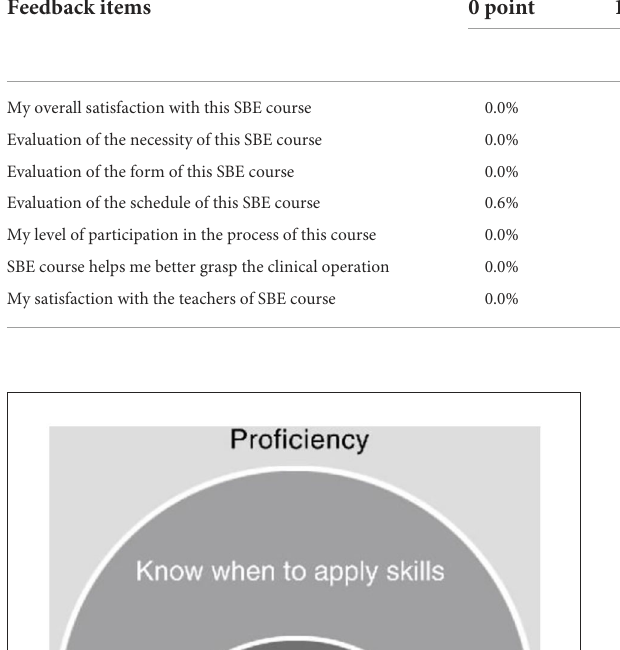
TABLE 2 The feedback of students in the SBE group.